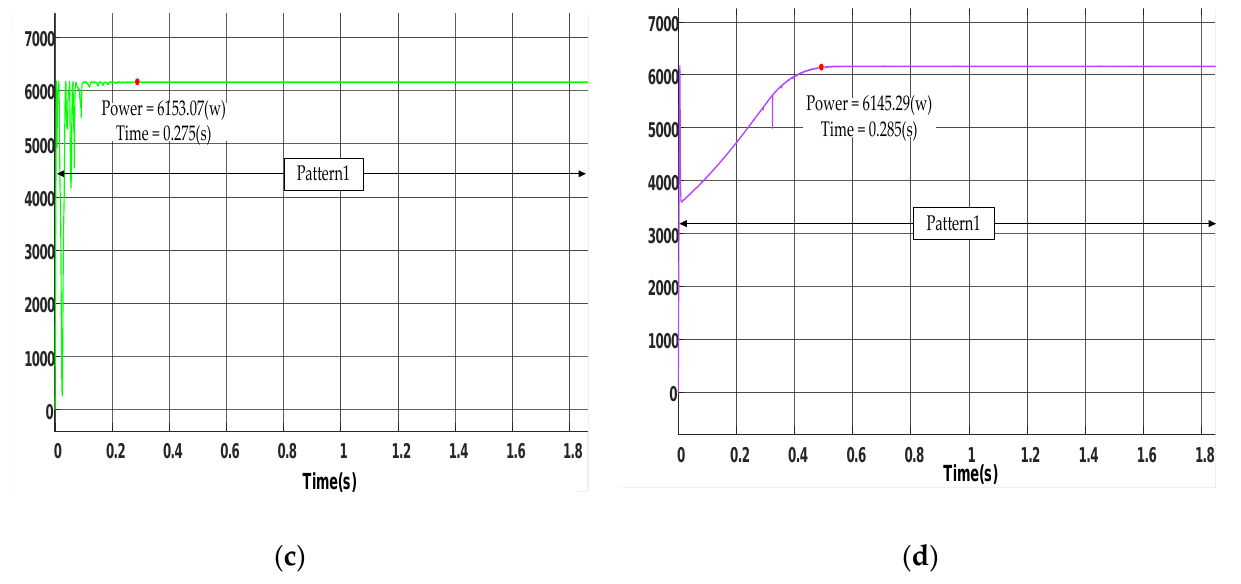
Figure 9. The obtained power by the algorithms in constant irradiance condition from pattern 1. ( a ) TSO; ( b ) ITSO-INC; ( c ) CS; ( d ) INC. Table 8. Numerical results of TSO, ITSO-INC, CS, and INC methods in pattern